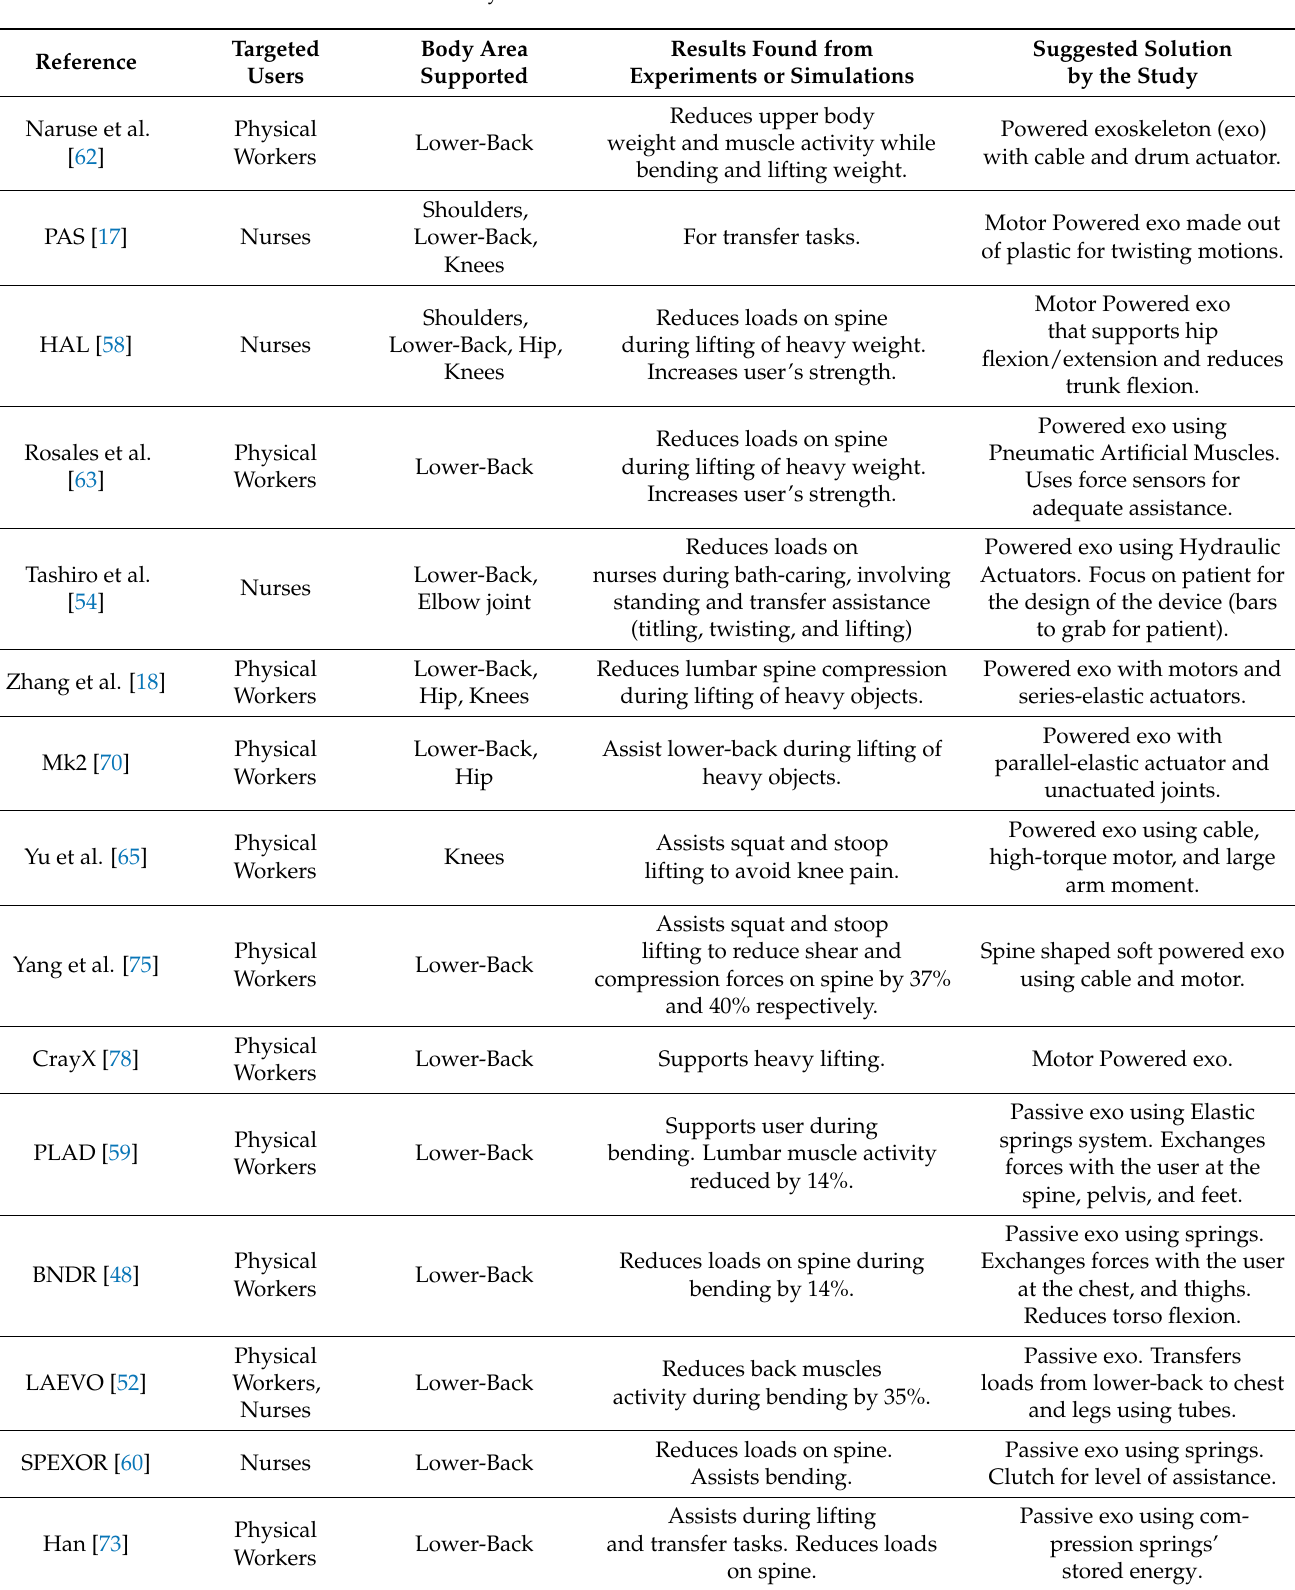
Table 4. Summary of the Reviewed